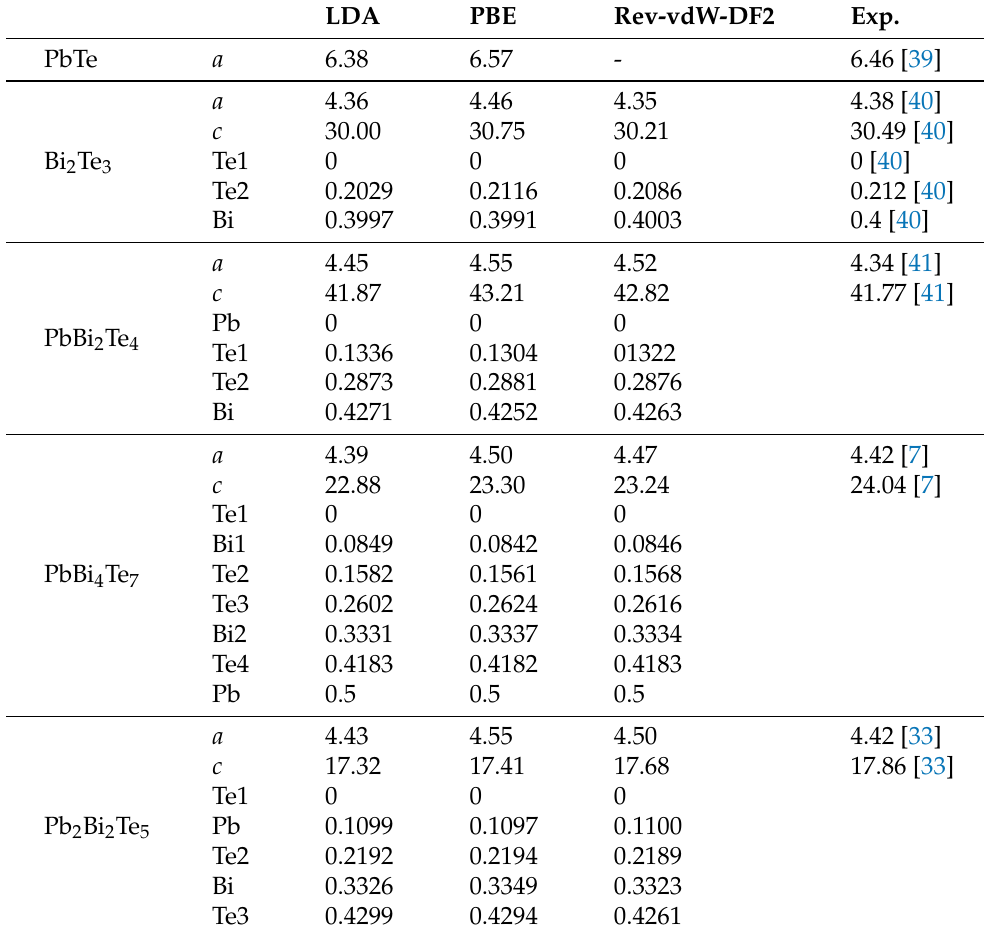
Table 1. Calculated lattice parameters (Å) and atom fractional coordinates along the c axis for Bi 2 Te 3